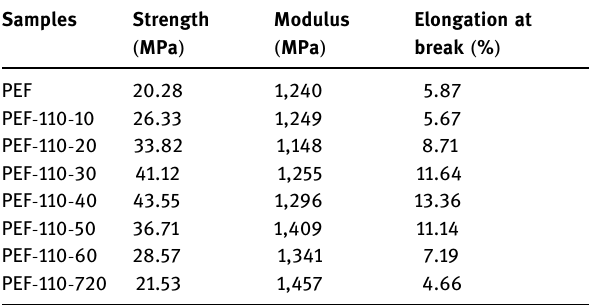
Table A4: Mechanical properties of PEF - 110 - t